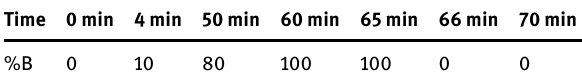
Table 3: Gradient pro fi le used for the peptide SCX separation